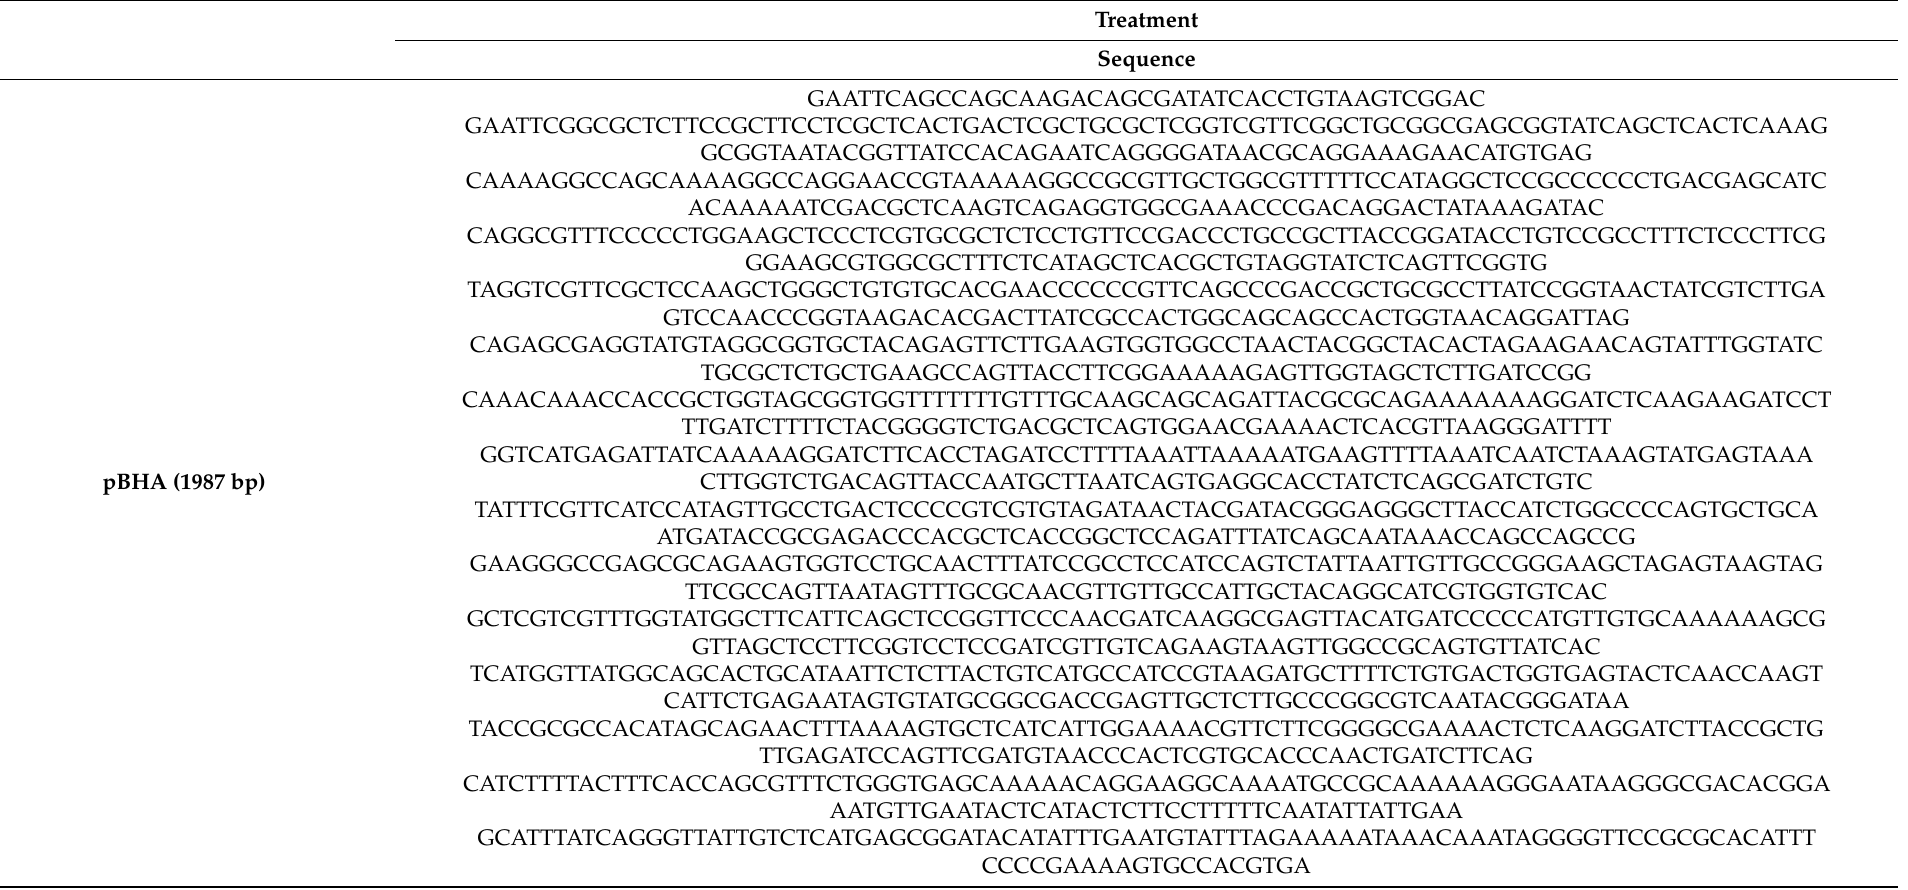
Table 1. Sequences of pBHA, LegH, and pBHA +